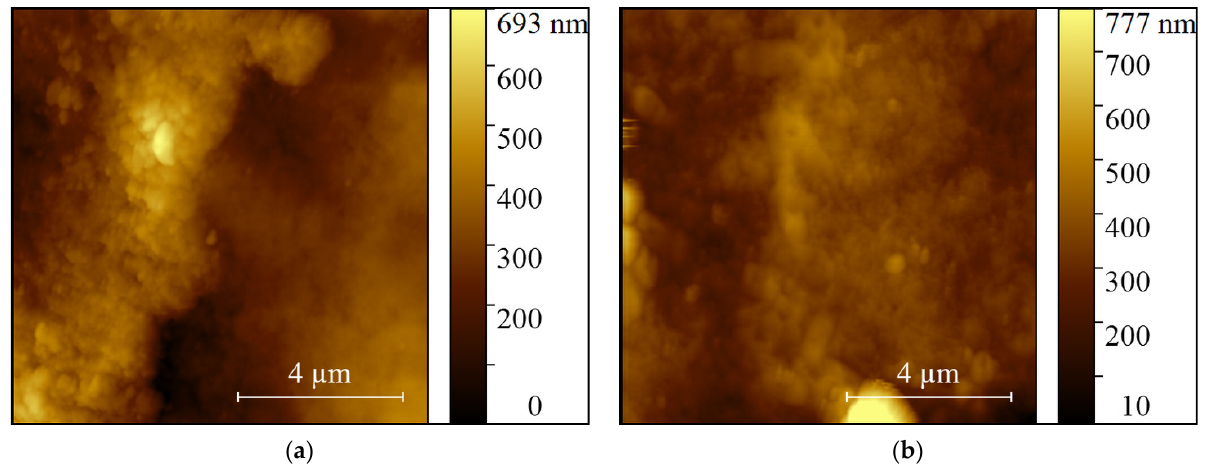
Figure 2. AFM topography of teeth surface: ( a ) mouse from the control group; ( b ) mouse from the PAW treated group.